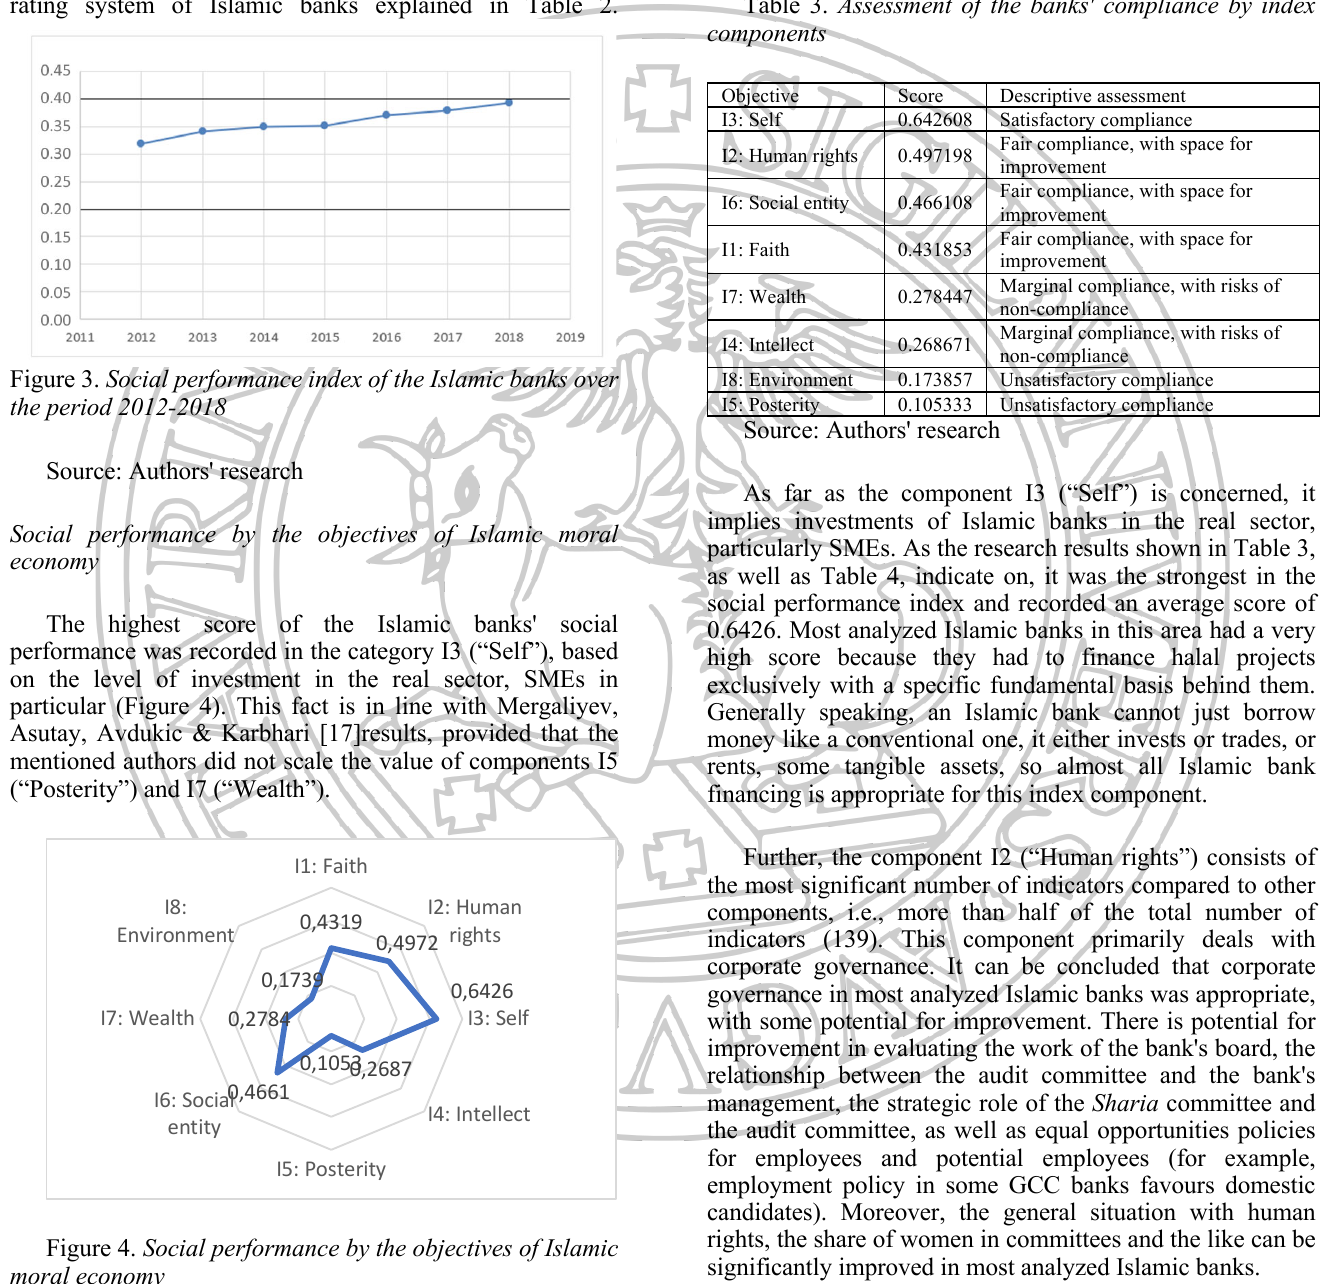
Figure 4. Social performance by the objectives of Islamic moral economy